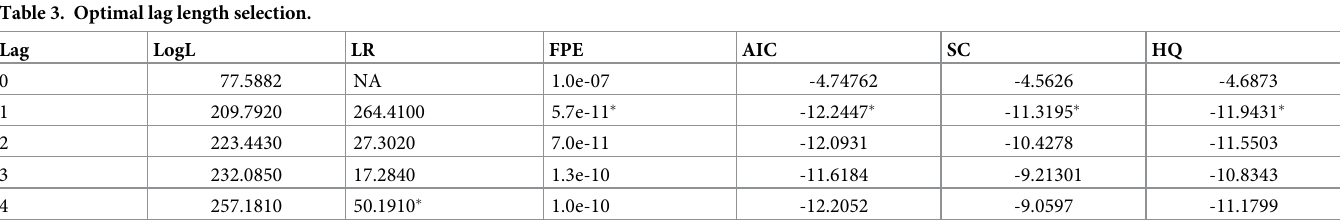
Table 3. Optimal lag length selection.